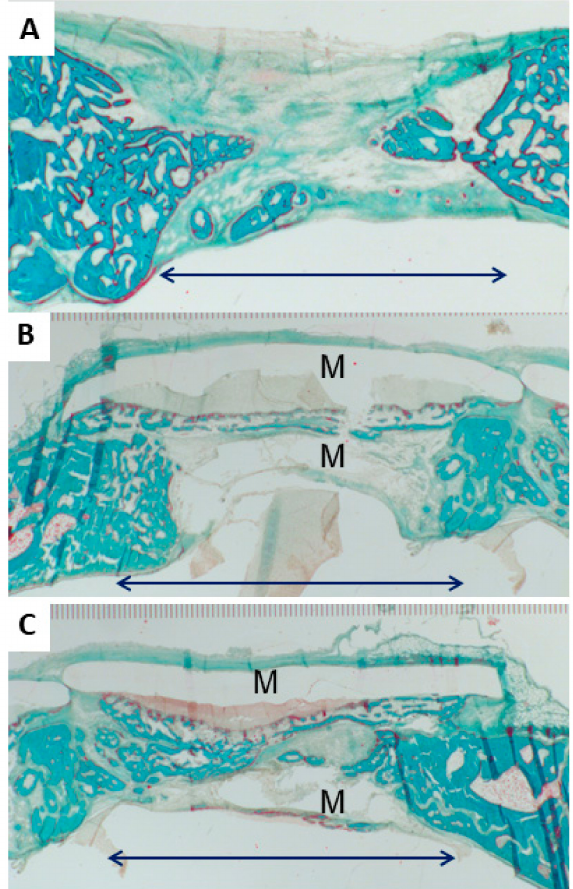
Figure 4. Goldner’s Trichrome staining of calvarial defects treated with poly-lactide-co-glycolide (PLGA)-basedmembranes( A )emptycontroldefect, ( B )defecttreatedwithtwonativePLGAmembranes (membrane no DMA), ( C ) defect treated with two PLGA membranes loaded to 10 wt % with DMA (membrane vapor 10%). M marks the transparent layer of the membranes placed above and below the defect. Black arrows indicate the defect width of six mm. Trichrome stains the bone in a greenish-blue color and the osteoid in red.